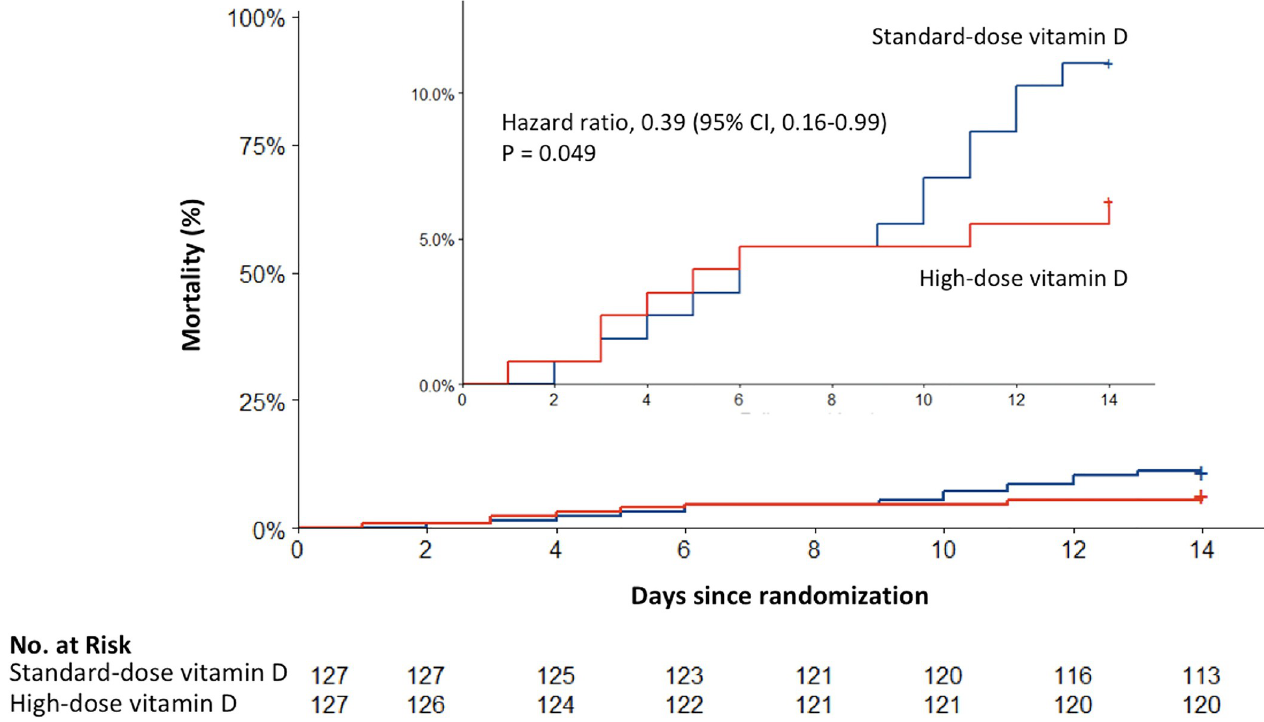
Fig 2. Effect of allocation to high-dose or standard-dose vitamin D3 on 14-day mortality. Overall death at 14 days (the primary outcome) occurred in 8 of 127 patients (6%) in the high-dose vitamin D group and in 14 of 127 patients (11%) in the standard-dose vitamin D group. The insert shows the same data on an expanded y axis. CI, confidence